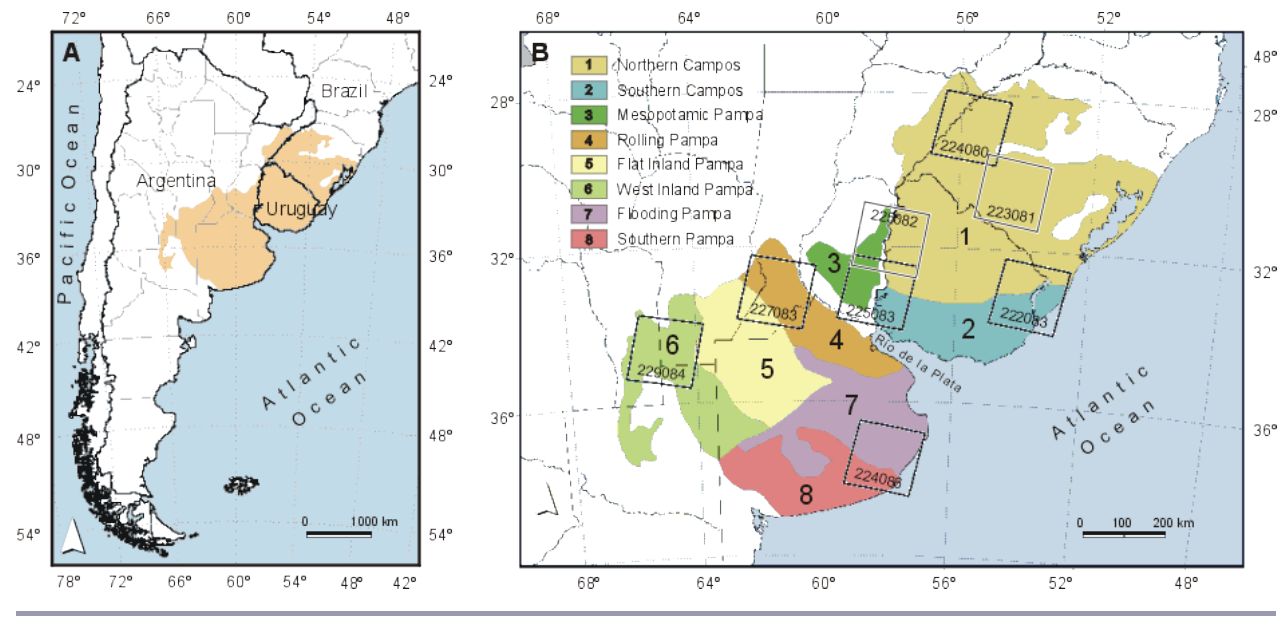
Fig. 1. (A) Location of the Río de la Plata Grasslands (RPG) ecosystem (in orange). (B) Subunits and pilot areas within the RPG; numbers within boxes correspond to the path/row of the Landsat scene. Internal political subdivisions are shown only within Argentina and Brazil (gray